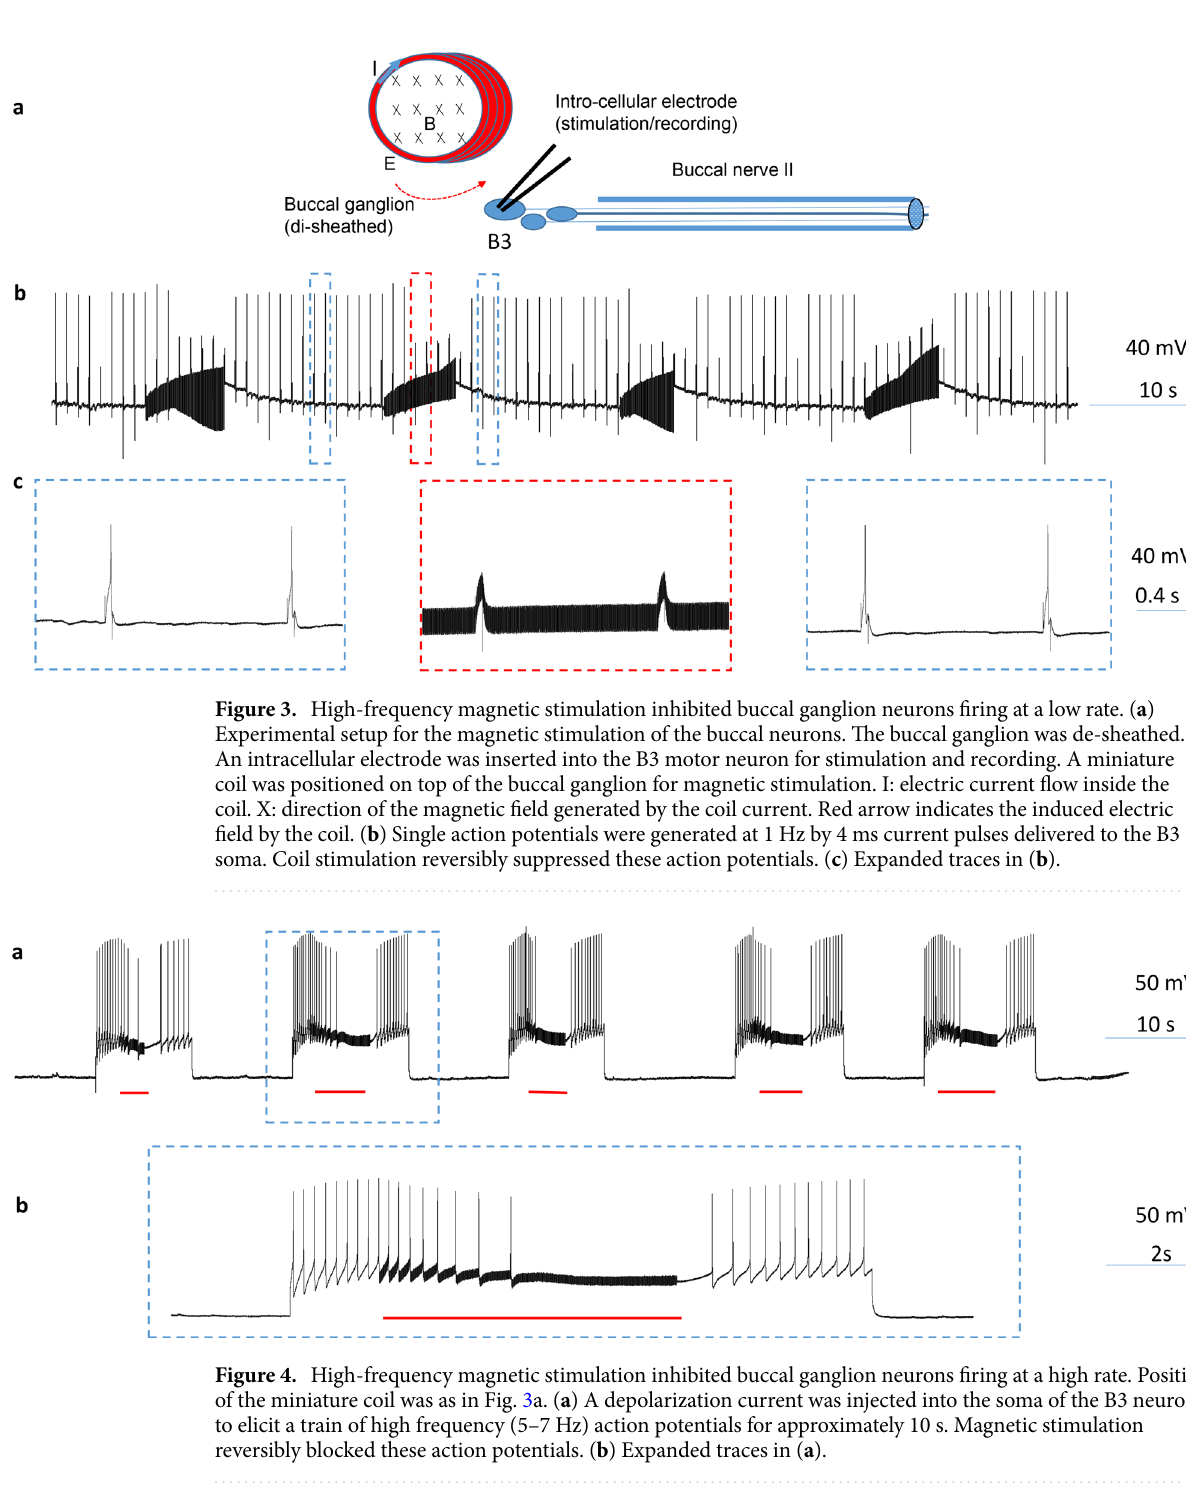
an overall inhibition of the ganglion activity by the magnetic stimulation.